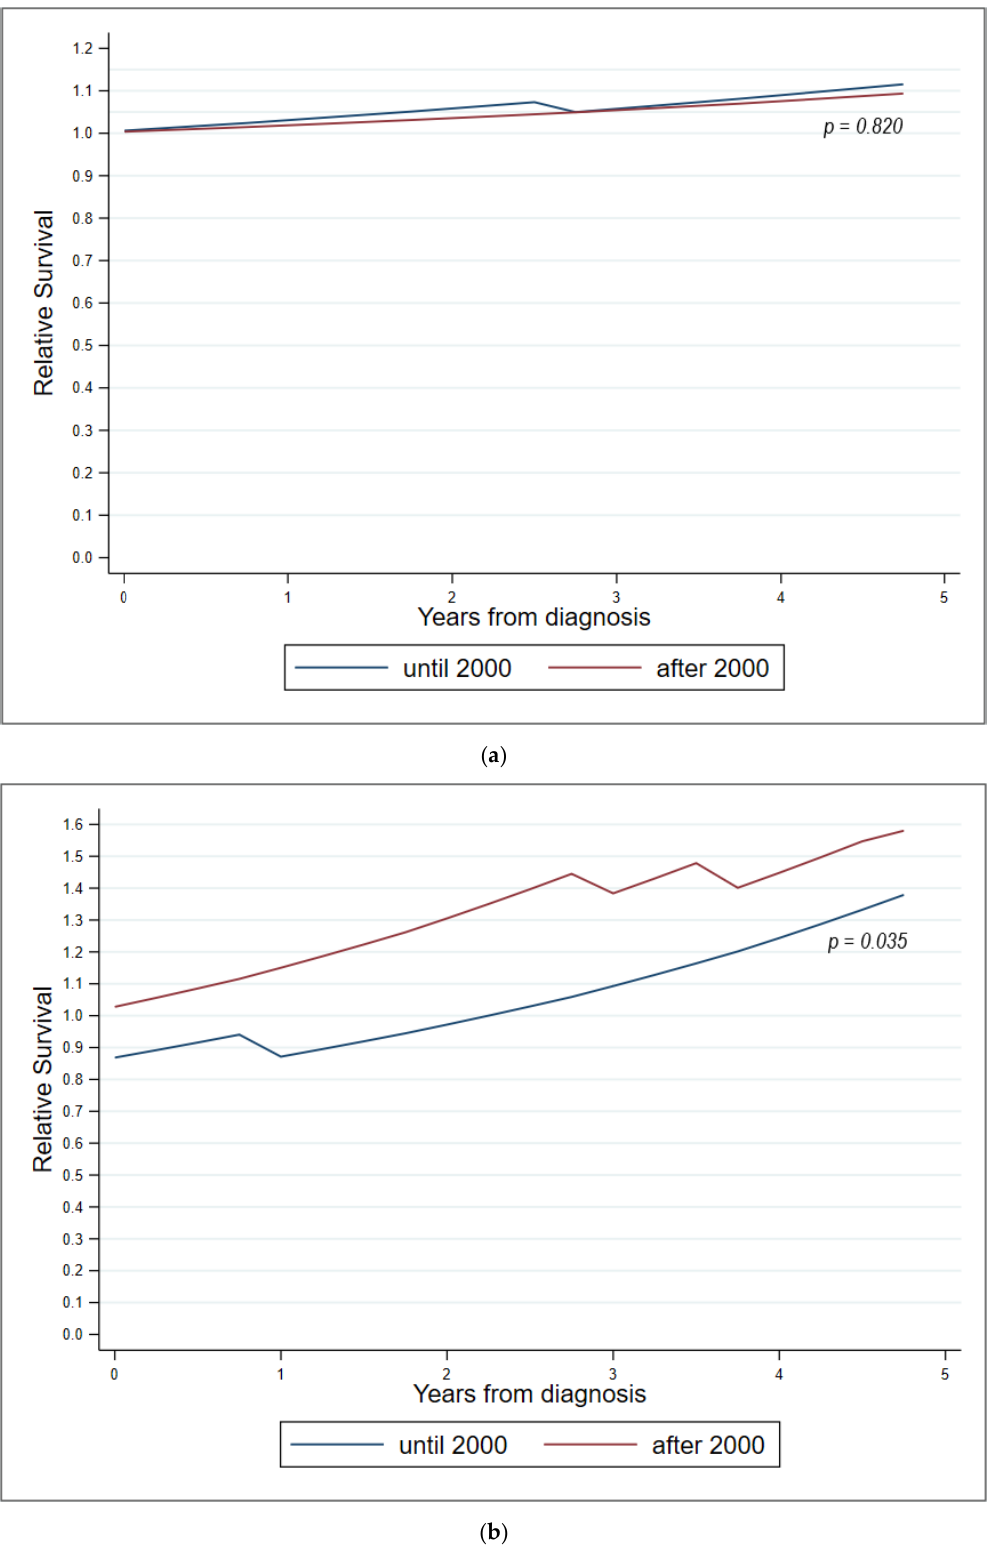
Figure 6. Survival comparison with a matched cohort from the Tyrolean general